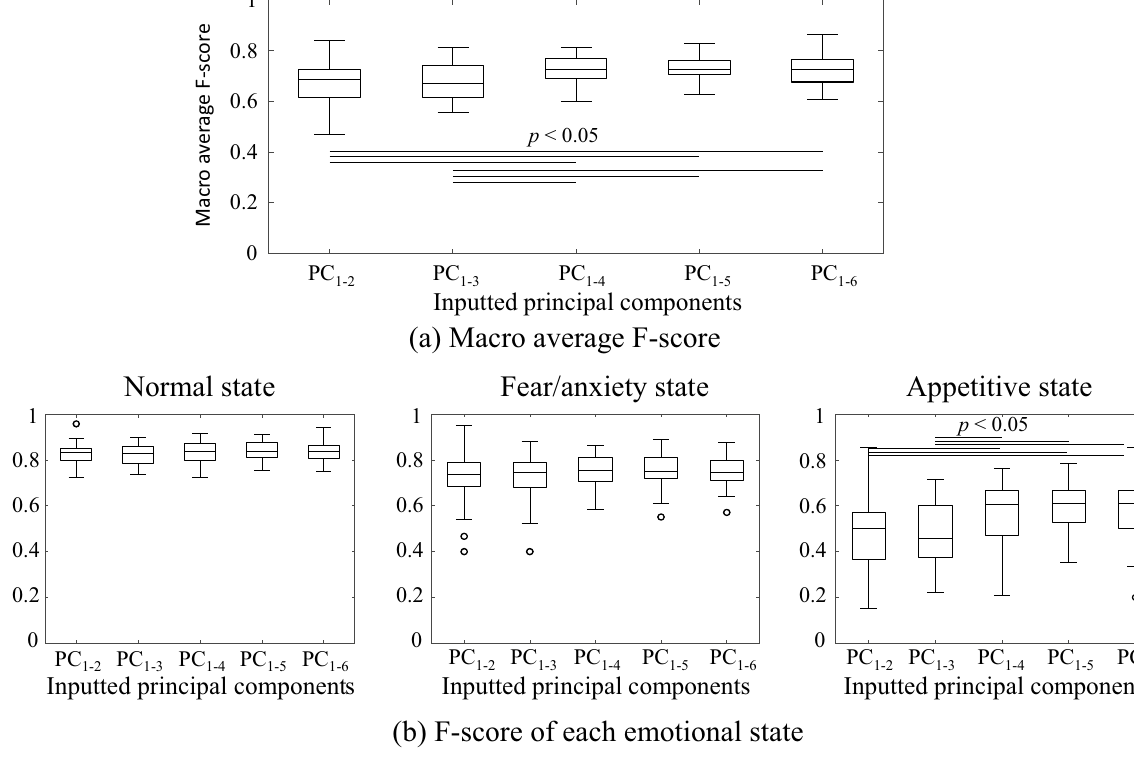
Figure 9. F-scores obtained from LLGMN. ( a ) Boxplot of macro average F-scores for all emotional states. ( b ) F-scores of each emotional state. In the macro average and the appetitive state, the F-scores of PC 1–4 , PC 1–5 , and PC 1–6 are significantly higher than those of PC 1–2 and PC 1–3 .